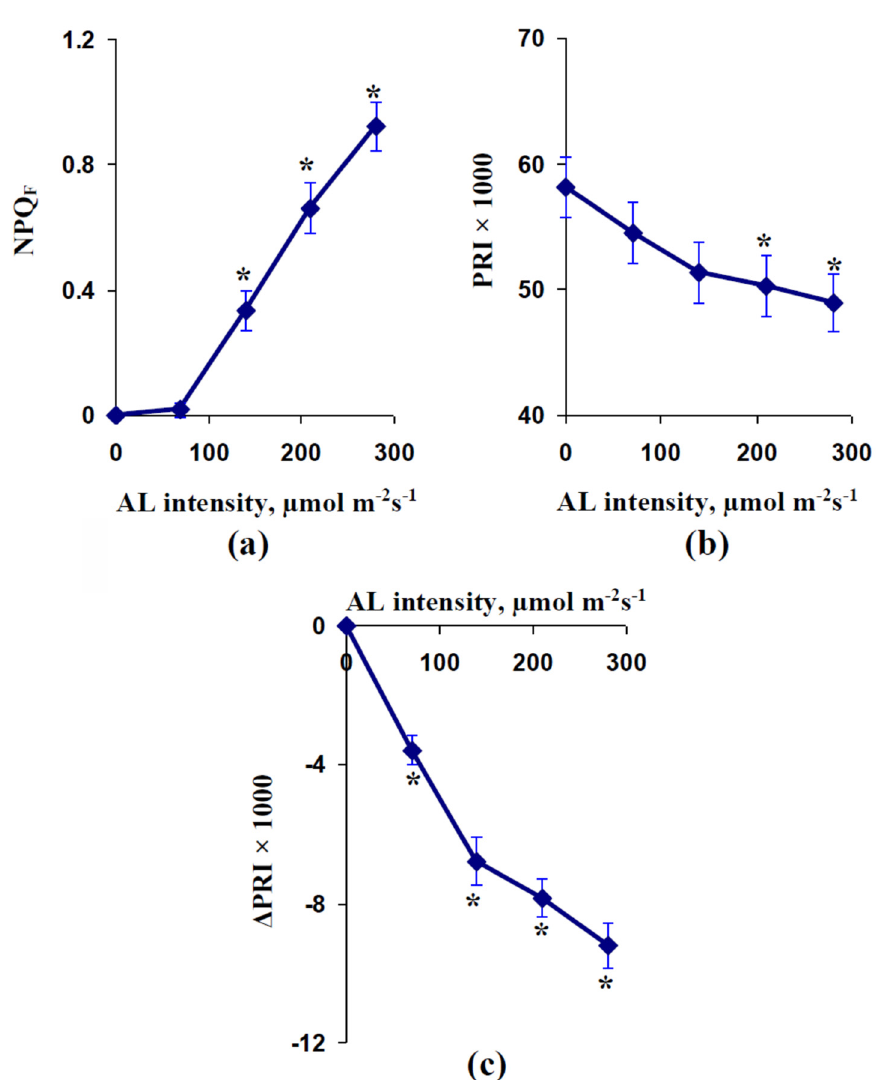
Figure 4. Dependences of the energy-dependent component of the non-photochemical quenching of fluorescence (NPQ F ) ( a ), the absolute value of PRI ( b ), and its change ( Δ PRI) ( c ) in leaves of pea seedlings on intensity of the actinic light (AL, 617 nm) ( n = 16). Measurements were initiated after 15 min dark adaptation. Durations of AL actions with different intensities were 5 min followed by 5 min dark interval after each illumination. The absolute value of PRI was measured before termination of illumination. Δ PRI was measured as the difference between PRI measured before termination of illumination with specific AL intensity and the initial PRI measured before initiation of the first illumination. * indicates that the value of the parameter significantly differed ( p < 0.05) from the value before initiation of the first illumination. n is number of repetitions. Bars show standard errors.